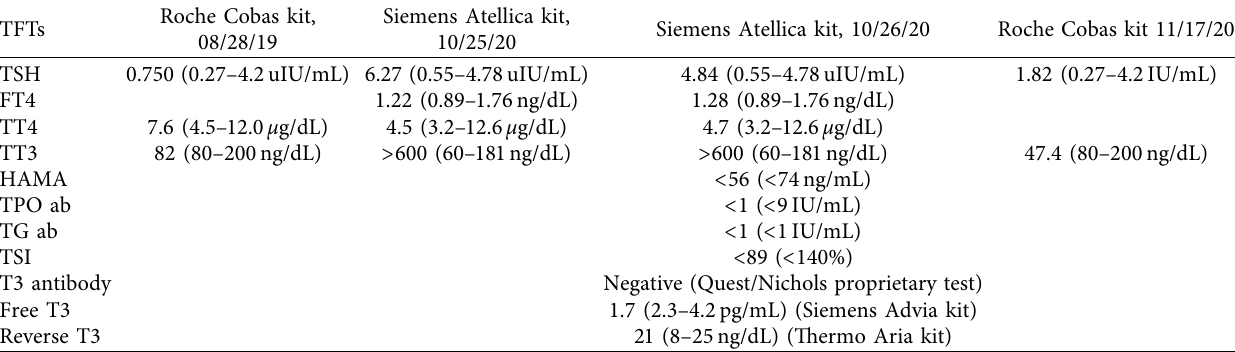
Table 1: Summary of laboratory